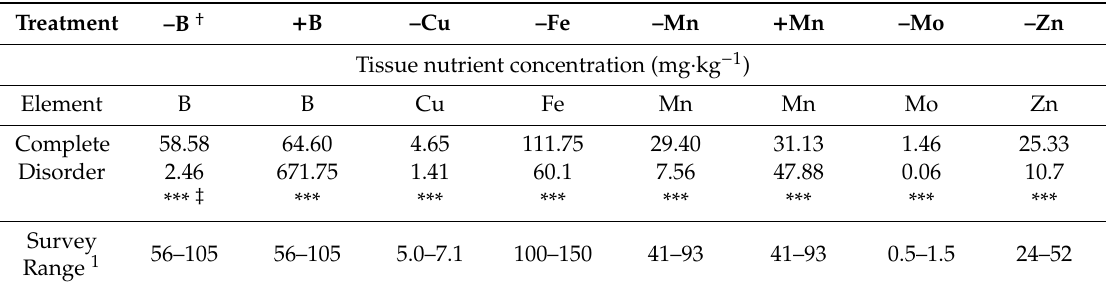
Table 4. Foliar nutrient concentrations of Cannabis sativa ‘T1’ grown with a deficient micronutrient treatment compared to plants grown with a complete fertilizer regime.